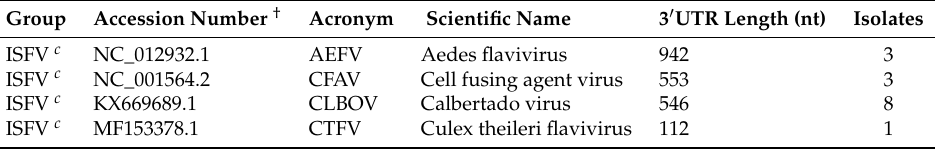
Table A1. Viral genomes considered in this study. Flaviviruses are categorized into the groups tick-borne flaviviruses (TBFV), insect-specific flaviviruses (ISFV) and no-known-vector flaviviruses (NKV). The length of the 3 (cid:48) UTR is listed for each isolate. † Representative accession number from the refseq database. Whenever a refseq genome was not available, the isolate with the longest 3 (cid:48) UTR was selected as representative species. a Mammalian TBFVs. b Seabird TBFVs. c Classic ISFVs. d Dual-host affiliated ISFVs. e Rodent-associated NKVs. f Bat-associated NKVs. N / A 3 (cid:48) UTR partial or not